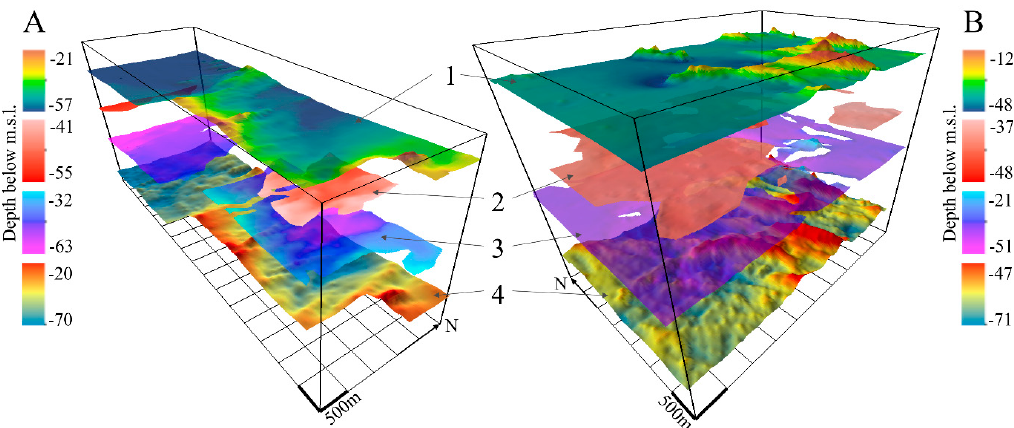
Figure 9. A 3D model of acoustic surfaces based on SBP processing; ( A ) Moschny Island key area, ( B ) Vyborg Bay key area. Geological interpretation of surfaces consists of: 1 = recent bottom surface, 2 = inner erosion surface of Holocene mud, 3 = surface of Late Pleistocene clays, 4 = till surface.